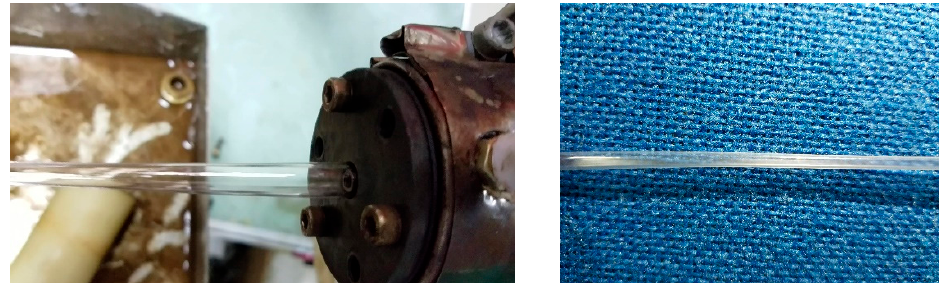
Figure 14. Micro-tube formation under 5000 Pa.